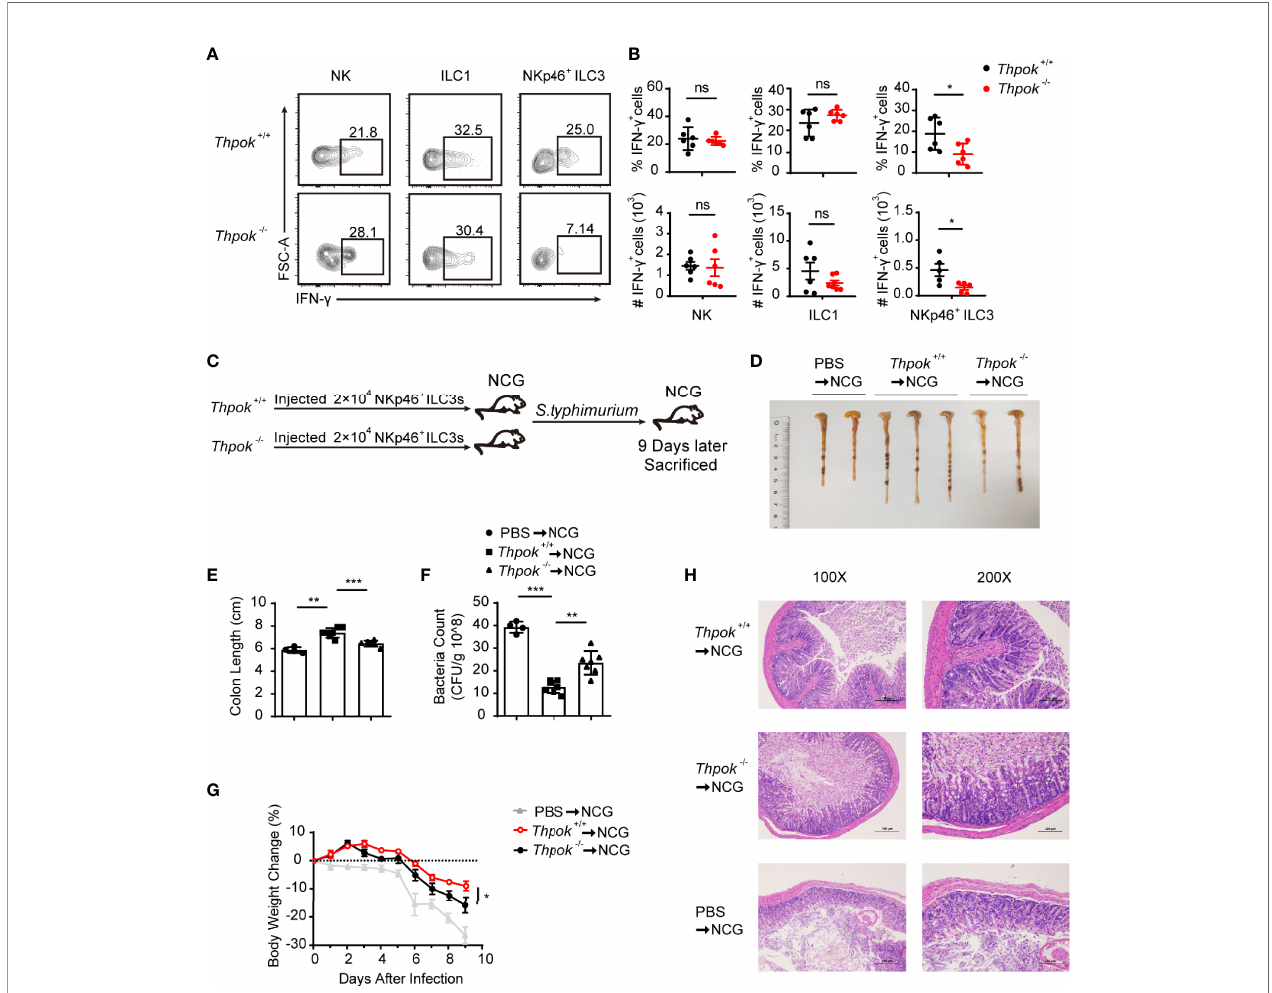
FIGURE 3 | Defective function of NKp46 + ILC3s resulted in sensitivity to S. typhimurium infection after ThPOK deletion. (A, B) Cytokine production in siLP ILCs from ThPOK-de fi cient mice and their WT littermates. Cells were stimulated for 4 h in vitro with PMA and ionomycin for IFN- g production. (A) Representative fl ow plots and (B) quanti fi cation of IFN- g production from NK cells (left), ILC1s (middle), and NKp46 + ILC3s (right) after stimulation with PMA and ionomycin. (mean ± SEM; n = 5-6; * P < 0.05, Student ’ s t test). (C) NCG mice were adoptively transferred with 80000 intestinal NKp46 + ILC3s sorted from ThPOK-de fi cient mice and their WT littermates or PBS as control after treated with ABX for 1 week. NKp46 + ILC3s were injected to NCG mice through the tail vein. NCG mice were orally inoculated with S. typhimurium 24 hours post adoptive transfer. Body weight were monitored for 9 days, and all mice were sacri fi ced at day 9. (D, E) Colon length for NCG recipients after infection at day 9. (mean ± SEM; n = 4-7; ** P < 0.01, *** P < 0.001, Student ’ s t test). (F) Bacterial counts in the feces at day 9 after infection. (mean ± SEM; n = 4-7; ** P < 0.01, *** P < 0.001, Student ’ s t test). (G) Body weight changes at the indicated time points. (mean ± SEM; n = 6-11; * P < 0.05, Student ’ s t test). (H) Representative H&E staining of colon tissue sections. Data are representative of at least three independent experiments. ns, no signi fi cant